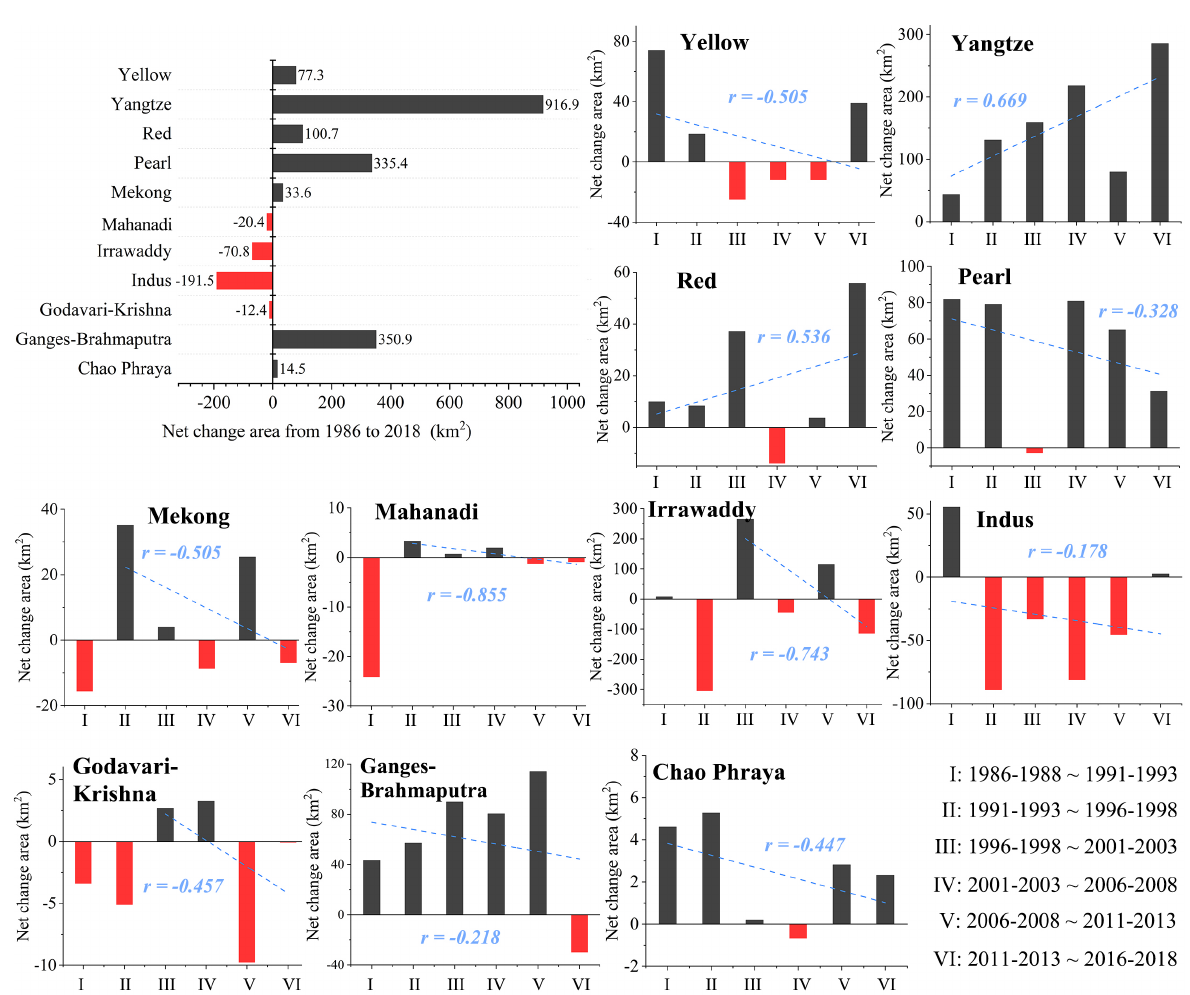
Figure 3. Net area change of Asian deltas from 1986 to 2018. Red bars indicate a net loss of deltaic lands, whereas black bars indicate a net gain of deltaic